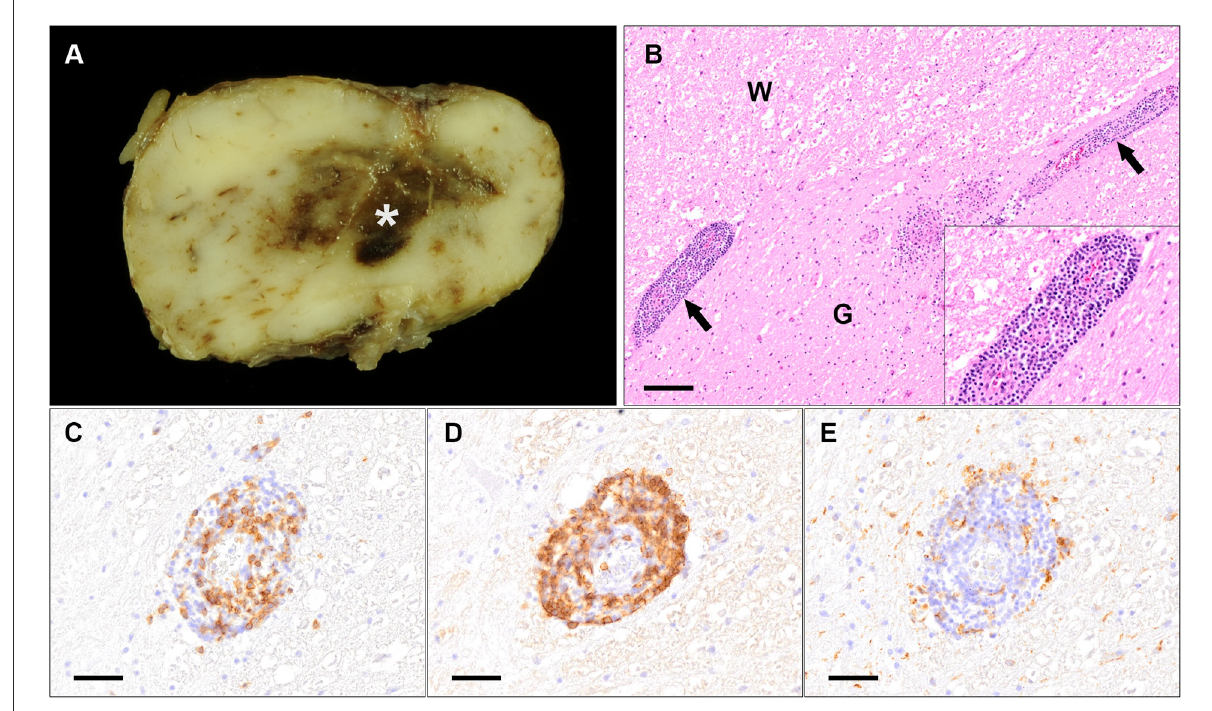
FIGURE5 Macroscopic and histopathological findings of a 10.75 year old Australian Shepherd (case 3). (A) Macroscopic image of the brain stem displaying focal, severe hemorrhage within the neuroparenchyma (asterisk). (B) Histopathology of the spinal cord shows severe, multifocal vasculitis characterized by infiltrating inflammatory cells in the damaged vascular wall and the perivascular space (arrows; insert displays higher magnification of the perivascular infiltrates) at the border between white matter (W) and gray matter (G) (HE stain; scale bar: 100 µ m). (C–E) Immunohistochemistry for CD3 (C) , CD20 (D) and CD204 (E) shows that the majority of inflammatory cells infiltrating and surrounding damaged vessels are comprised of many (B–D) and less T-lymphocytes (C) . Only very few infiltrating cells represent CD204-positive macrophages (E) (Scale bar: 50 µ